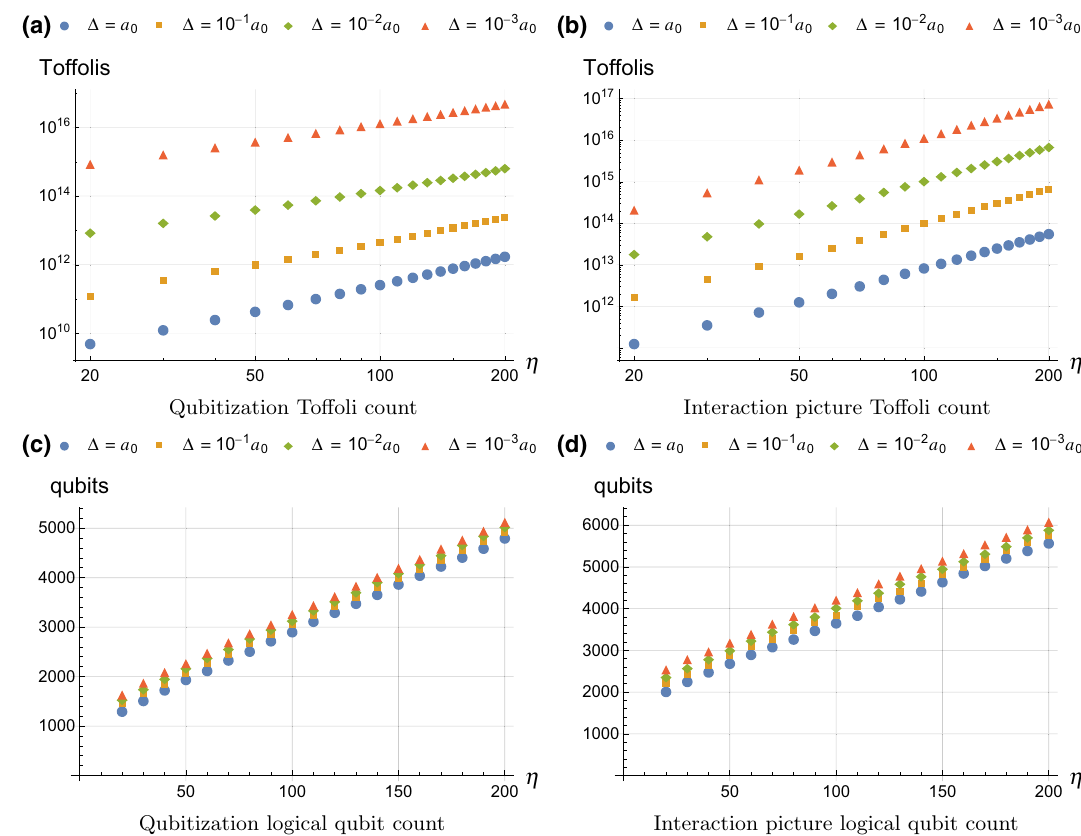
FIG. 1. Toffoli (top) and logical qubit (bottom) counts of the qubitization algorithm (left) and interaction-picture algorithm (right) as a function of η . Here we take (cid:9) = 0.0016 Hartree (corresponding to “chemical accuracy”) and N = 2 18 ≈ 2.6 × 10 5 but we note that outside of the dependence on (cid:19) , algorithm costs depend only logarithmically on N . For simplicity these plots correspond to the uniform electron gas (i.e., U = 0) but block encoding the external potential adds only marginal overhead so we expect these costs to be broadly representative of the resources required to simulate arbitrary molecular systems as a function of η and (cid:19) . We emphasize that (cid:19) = 10 − 3 a 0 is an excessively accurate discretization that would correspond to a grid of one billion points per each Bohr radius cubed of system volume. In most cases, we expect that a resolution of (cid:19) = 10 − 2 a 0 (which is one million grid points per Bohr radius cubed) would correspond to more accurate energies than large correlation consistent Gaussian basis sets. In the bottom panels we see that the qubit counts of the two algorithms are